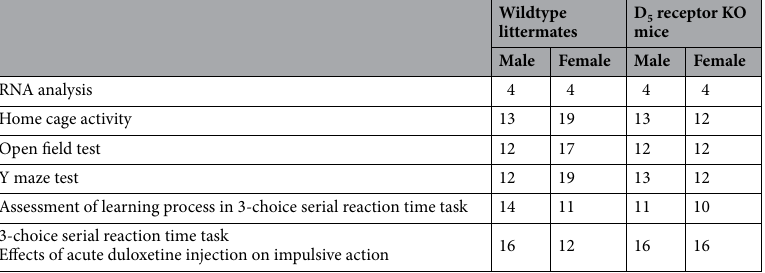
Table 2. Grouping of mice. The left column indicates the tests that mice on the right received. The numbers in each group are slightly different because we used littermates in each